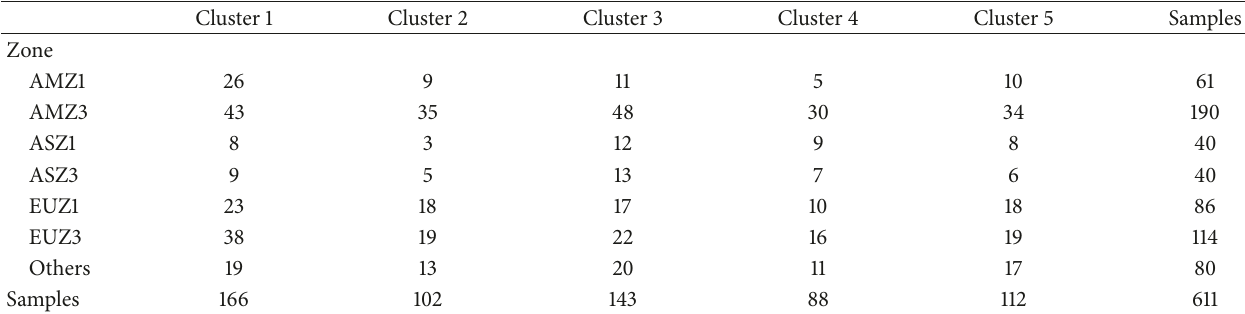
Table 10: Contingency table showing the distribution of geographical zone among the clusters (see Table 4 for details about the geographical zones).